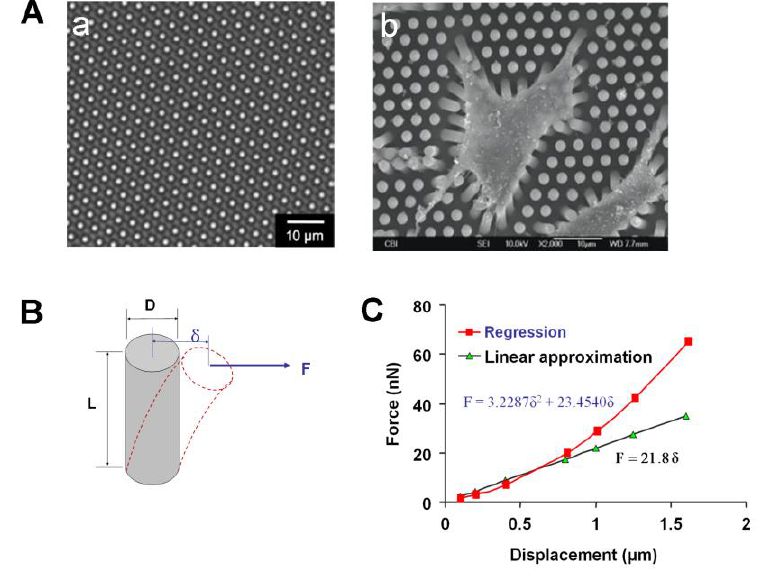
Figure 4. Micropost sensor array. A. (a) Microposts that are distributed on a silicone elastomer base. (b) Bending of microposts by a cell residing on top of the microposts (adapted with permission from Figures 5 and 6 in [42]). B. A single micropost. It functions as a cantilever beam and deflects under a pointed force (F), which represents a CTF. C. CTF calculation. When the deflection is small, the beam theory can be used to obtain a linear relationship between CTF and the deflection, or the displacement at the top of the micropost. When CTF is large, a non-linear relation between CTF and displacement has to be used for an accurate determination of the